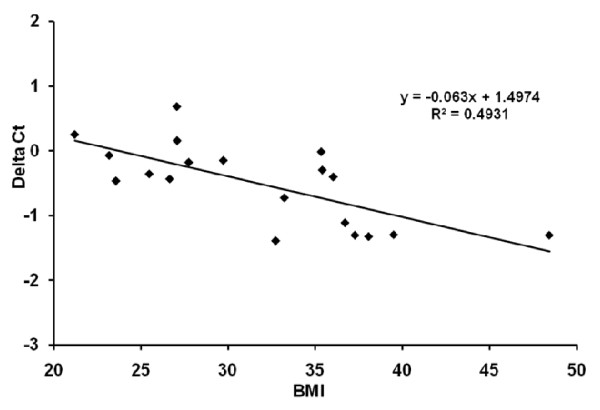
Regression plot of mir-21 expression levels in subcutaneous adipose tissue of healthy persons (n = 20) with a range in BMI (21-48). Data are presented as ΔCt levels (difference between Ct value for miR-21 and Ct value for control RNU48) versus BMI and thus represents a positive correlation between mir-21 expression levels and BMI, p < 0.001.